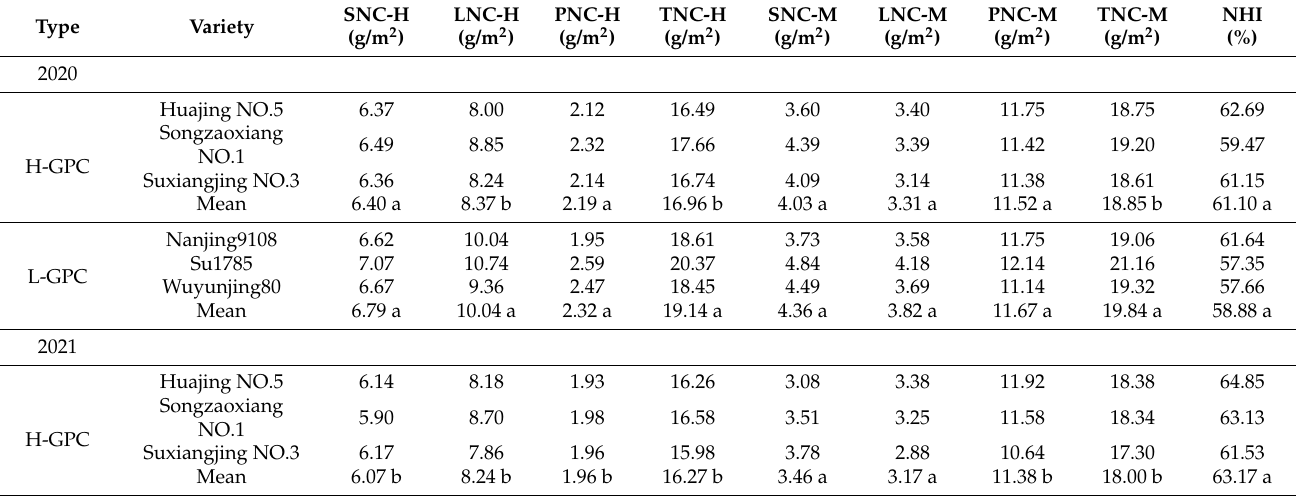
Table 4. Nitrogen accumulation, distribution at heading stage and